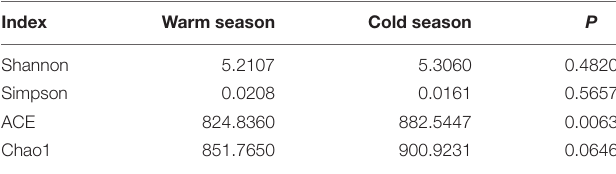
TABLE 2 | Effects of nutritional stress in cold season on diversity